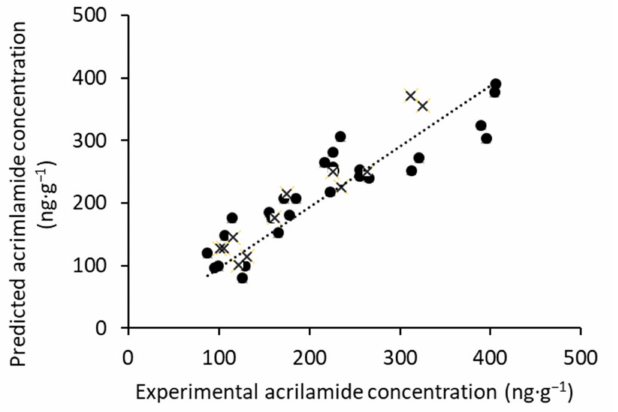
Figure 4. Correlation plot of calibration ( • ) and prediction ( × ) sets for the determination of acrylamide